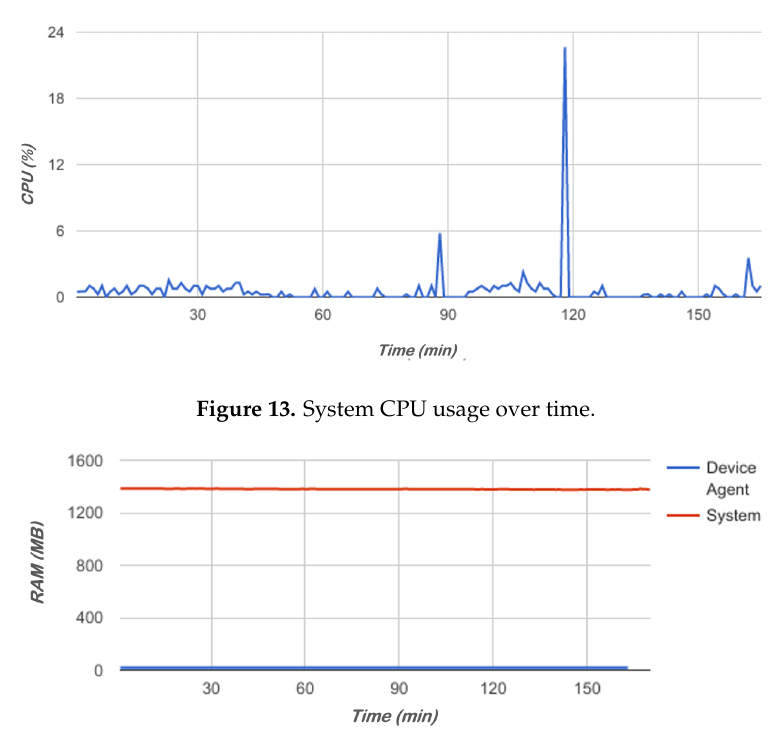
Figure 14. Available RAM over